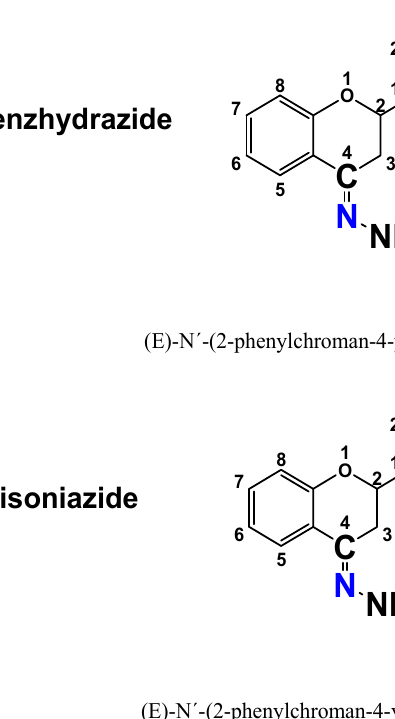
Figure 1. Formation of flavanone derivatives.